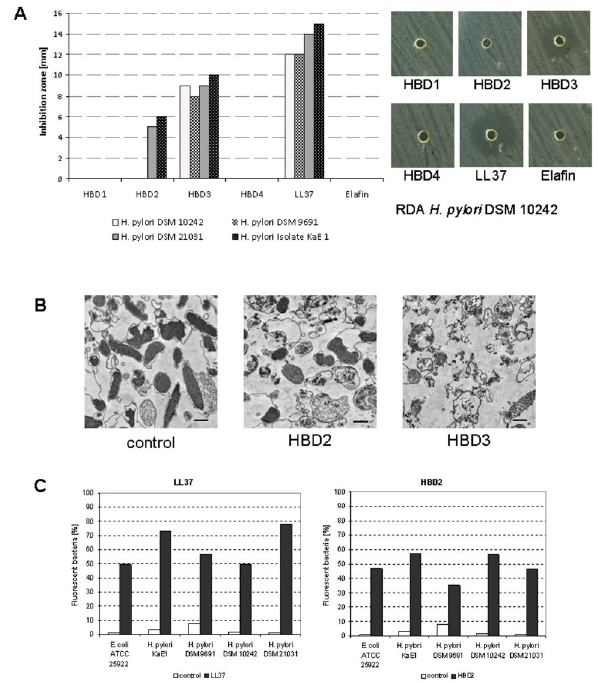
Figure 6. Radial diffusion assay, electron microscopy and binding experiments. In the RDA all four H. pylori strains displayed inhibition zones after incubation with 20 µg HBD3 or LL37, but not with HBD1, -4 or elafin. With HBD2 marginal growth inhibition was observed for two strains. Investigated with electron microscopy, cells of H. pylori KaE1 showed more pronounced disintegration with 200 µg/ml HBD3 than with 200µg/ml HBD2 (B). In flow cytometric experiments with biotinylated antibodies, HBD2 and LL37 bound to E. coli ATCC 25922 and Helicobacter pylori (C).